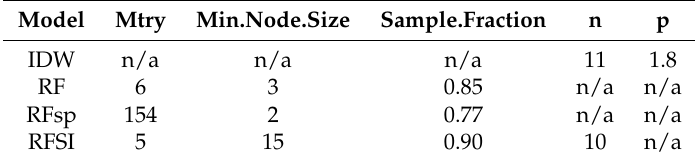
Table 6. Optimized hyperparameters of IDW, RF, RFsp, and RFSI for the temperature case study. Model